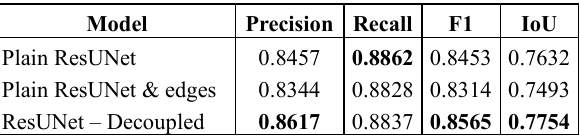
Table 1. Mean evaluation metrics per image for the validation dataset.